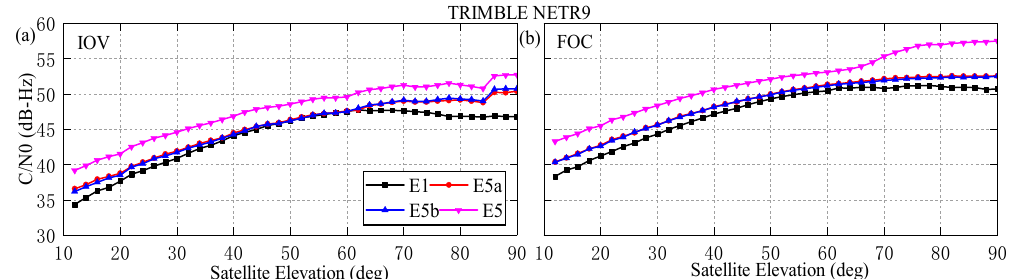
Figure 3. C/N0 values of Galileo signals against the satellite elevation for the receiver TRIMBLE NETR9 ( a ): IOV, ( b ): FOC.